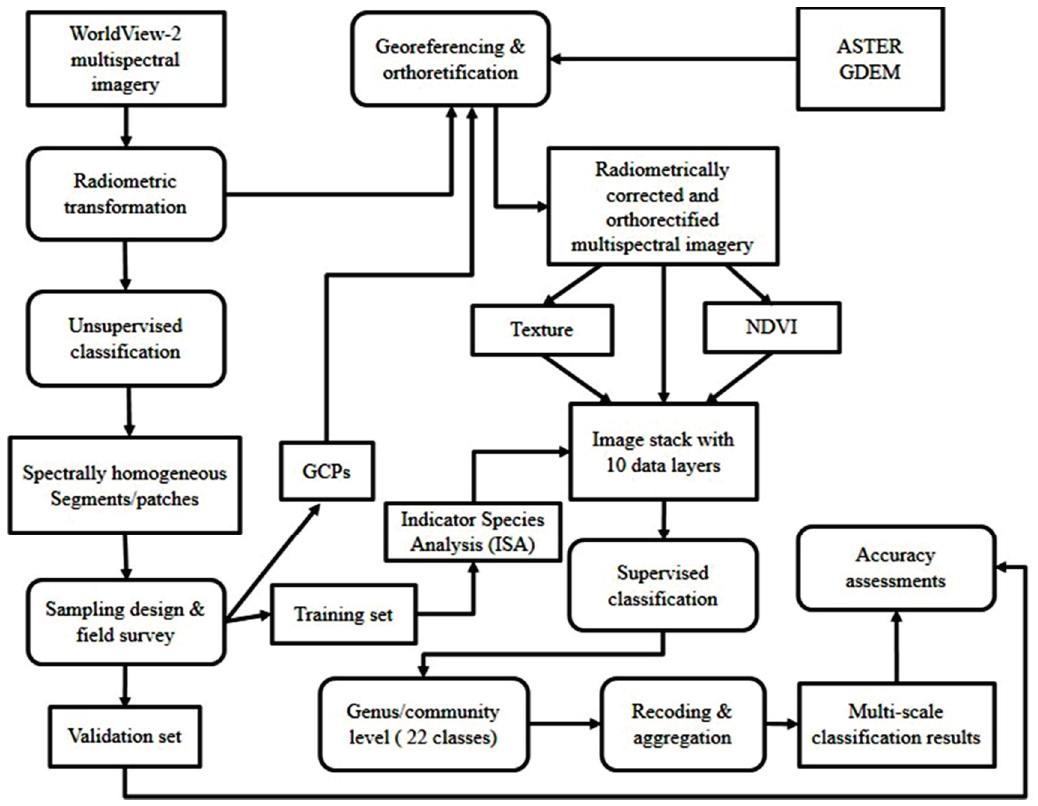
Figure 5. The data processing and information flow of the hybrid classification